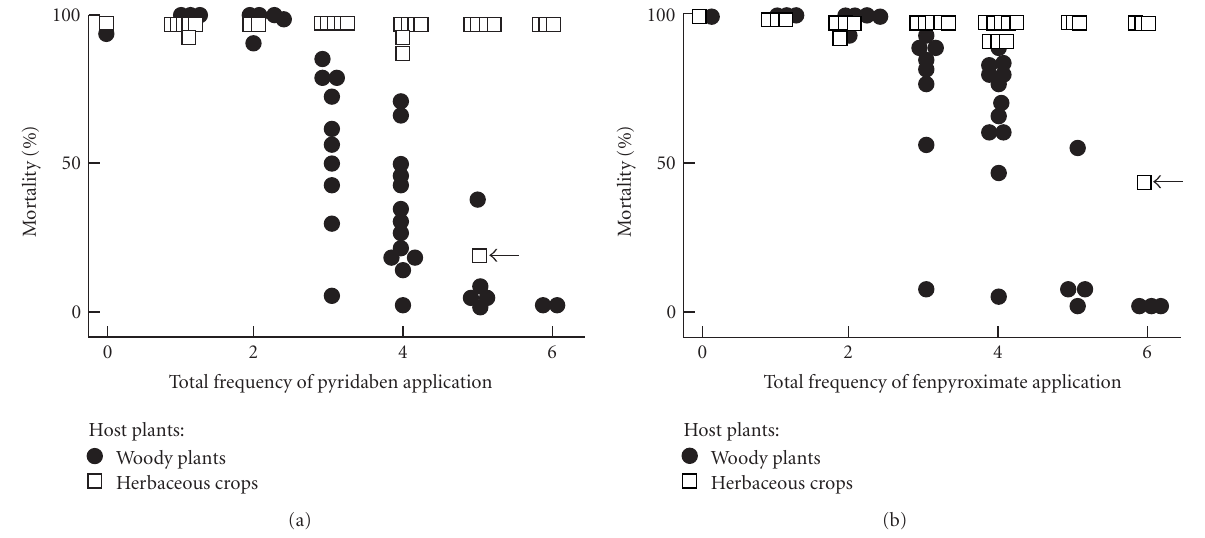
Figure 3: Correlation between total field applications of acaricides (200 mgL − 1 pyridaben; 50mg L − 1 fenpyroximate) and mortality for local